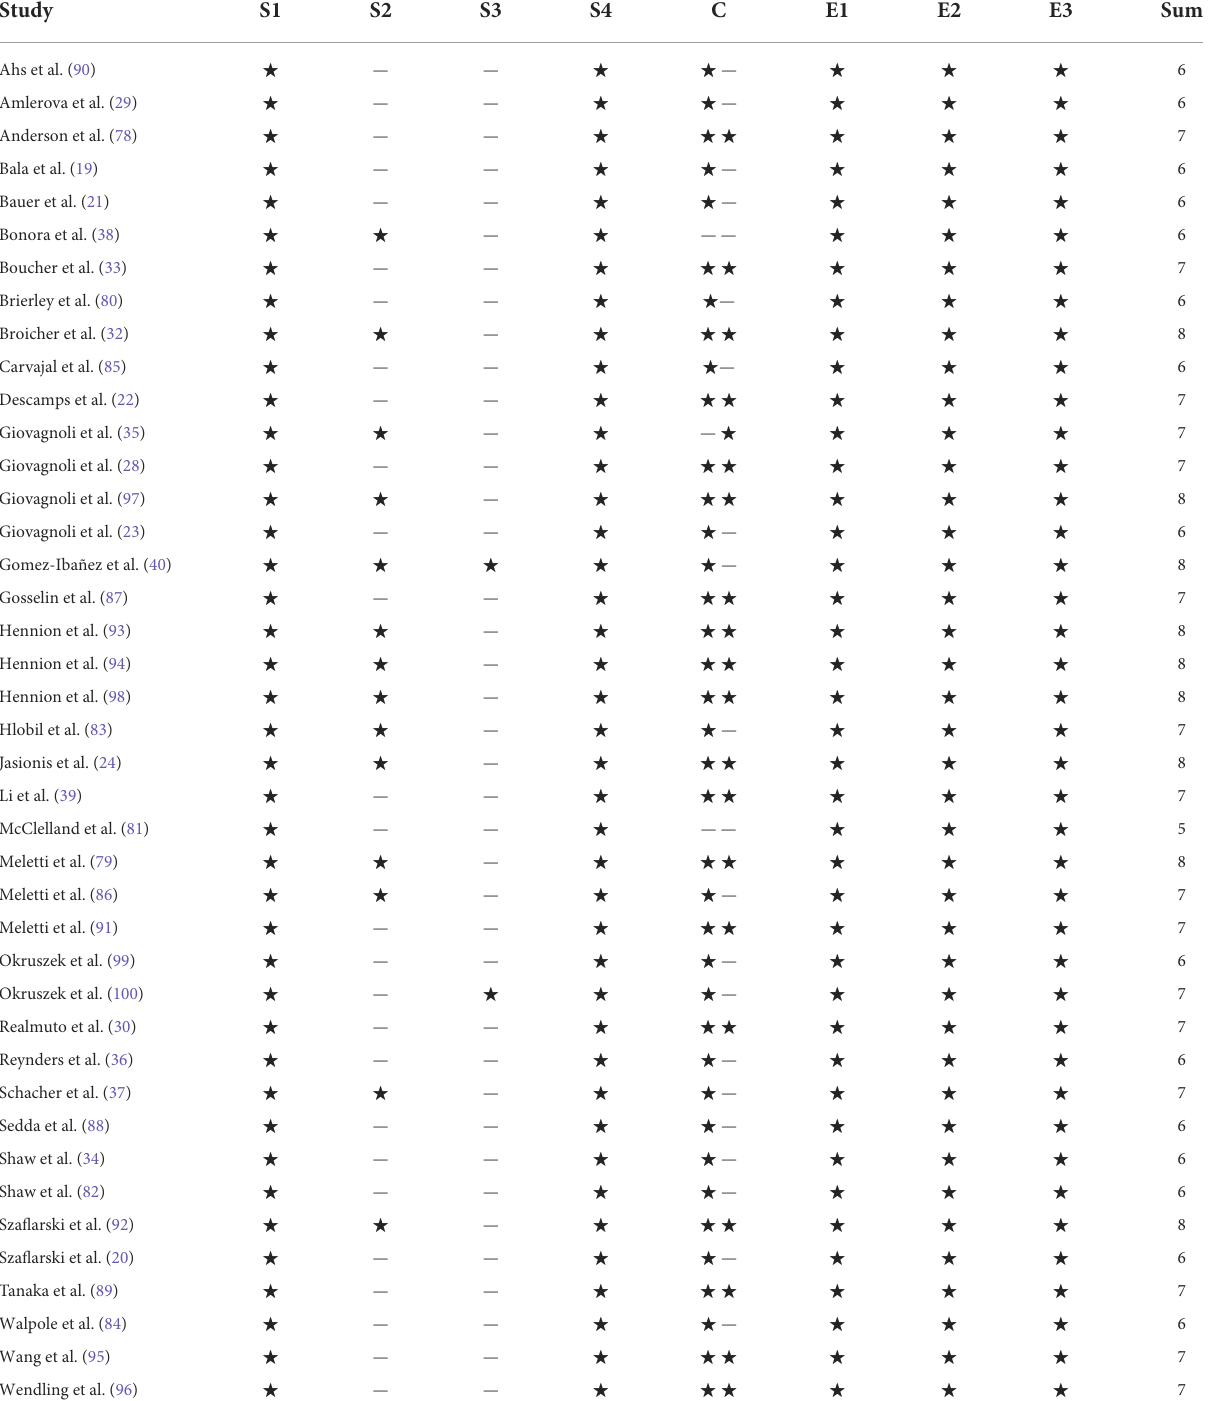
TABLE 2 Quality evaluation of included